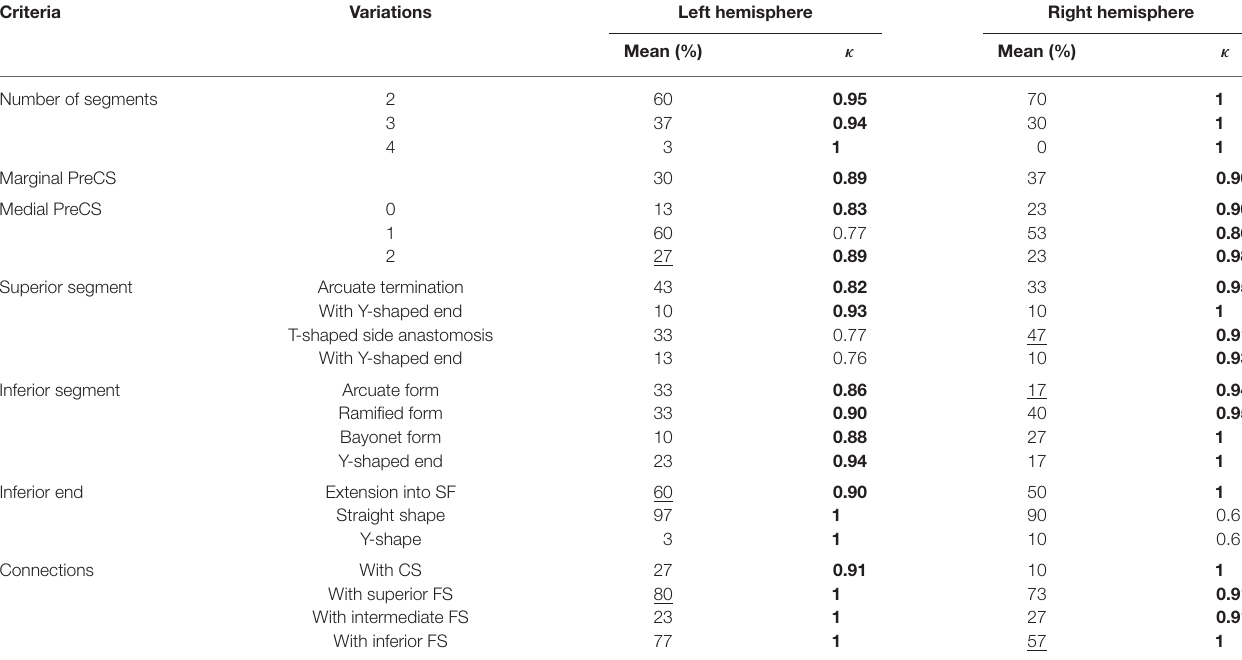
TABLE 5 | Mean occurrence frequency and inter-rater concordance of each sulcal criterion of the preCS in the left and right hemispheres.